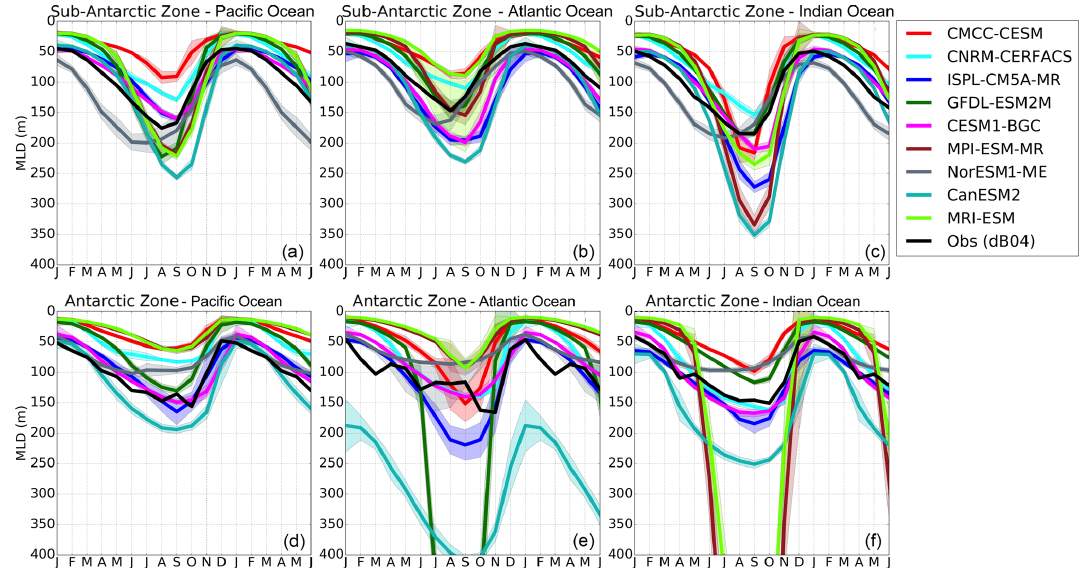
Figure 7. Seasonal cycle of the mixed layer depth (MLD) in the Sub-Antarctic and Antarctic zones of the Pacific Ocean (first column), Atlantic Ocean (second column) and Indian Ocean (third